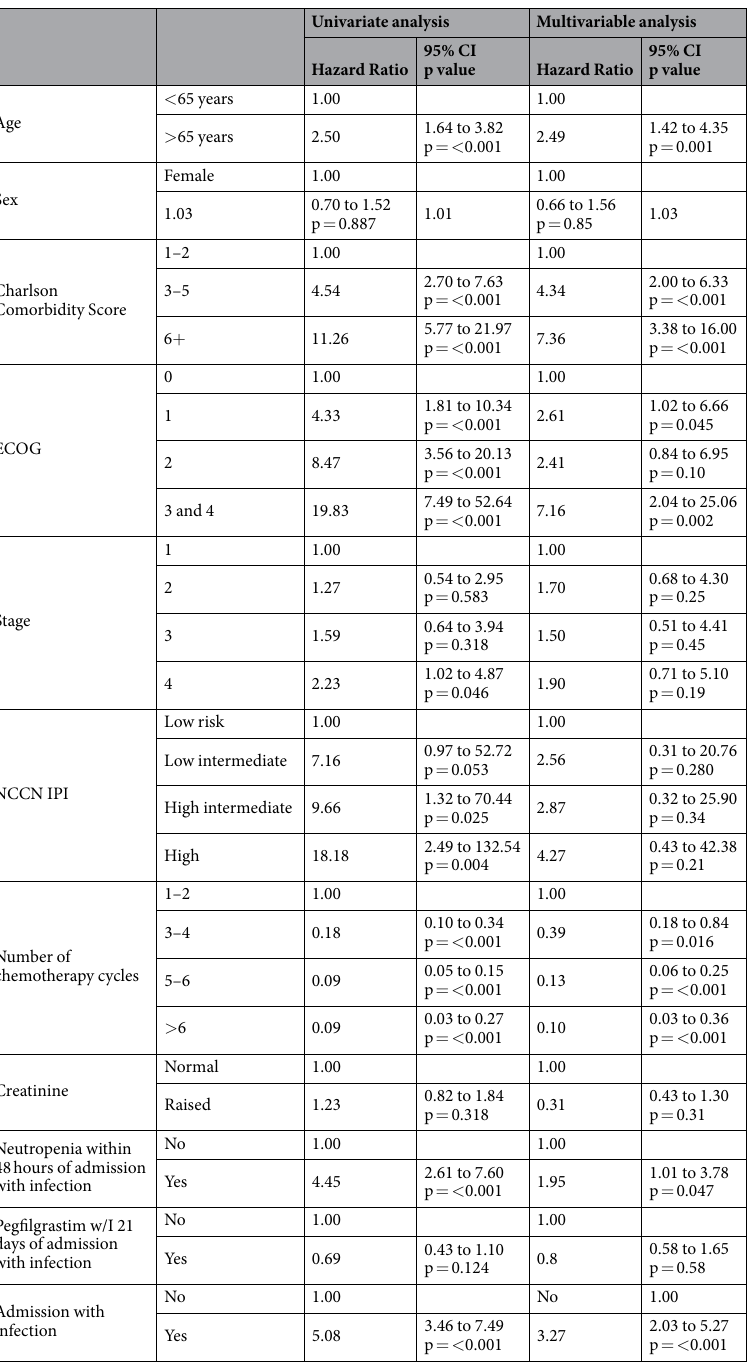
Table 6. Regression analysis of the factors associated with survival in all study patients (n = 325). ECOG = Eastern Cooperative Oncology Group performance status point scale. NCCN-IPI = International Prognostic